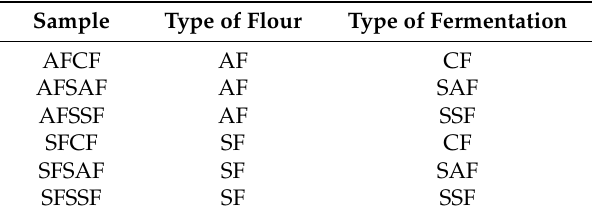
Table 1. Experimental breads. Sample Type of